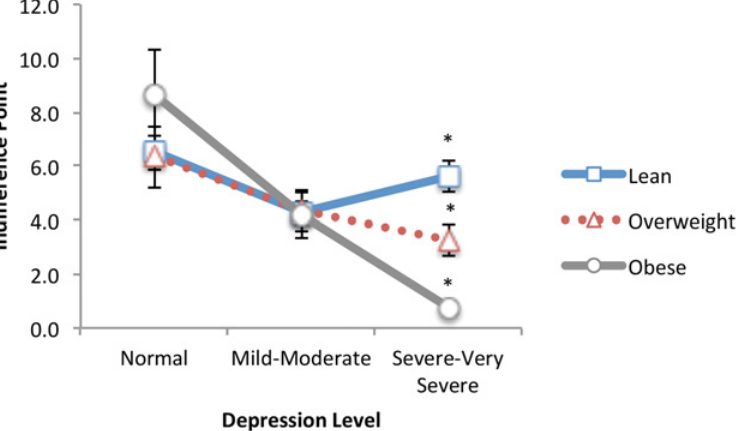
Fig 3. Fried Food: Delay discounting as a function of BMI and depression level for a fried food. At severe to very severe depression levels, participants who are overweight/obese show significantly greater impulsivity/lower control for a choice of a fried food compared to lean weight participants. * Significantly different from all other groups ( p < . 01).